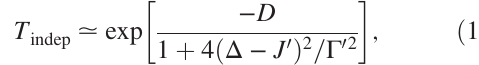
FIG. 12. Linear optics for a chain of N ¼ 20 atoms coupled to a nanofiber, for d ¼ λ 1 (b) reflectance, and (c) loss probability as a function of the atom-probe detuning. The blue curves are obtained by including the collective emission into free space [see Eq. (13)], and the red lines are produced within the “ independent emission ” model, where it is assumed that free-space emission is a single-atom effect [see Eq. (14)]. The parameters characterizing the nanofiber are given in Fig.